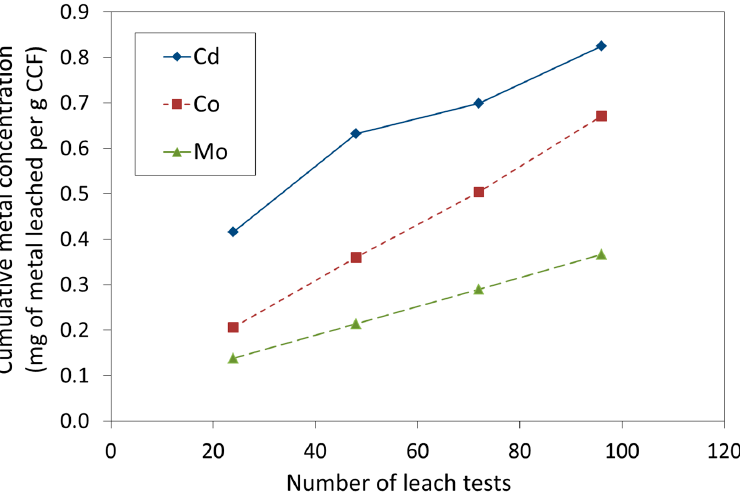
Figure 10. Cumulative concentration of metal species in distilled water leachate.